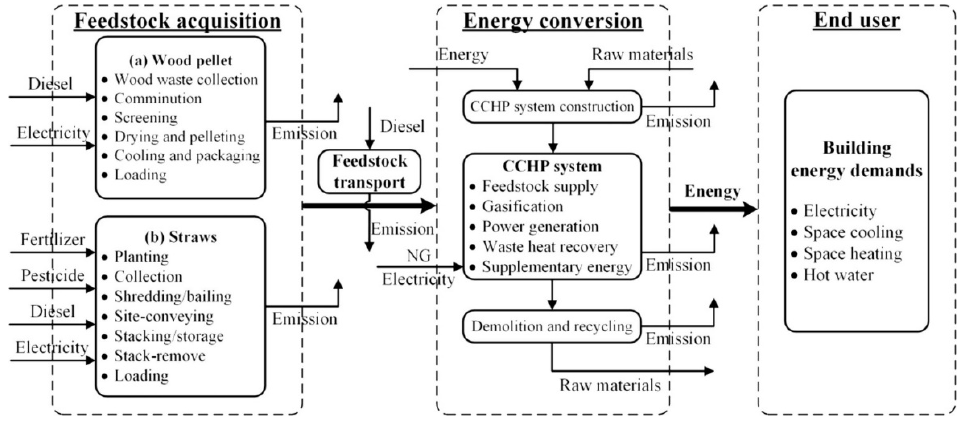
Figure 12. LCA boundary diagram of the biomass gasification-integrated CCHP system [89].